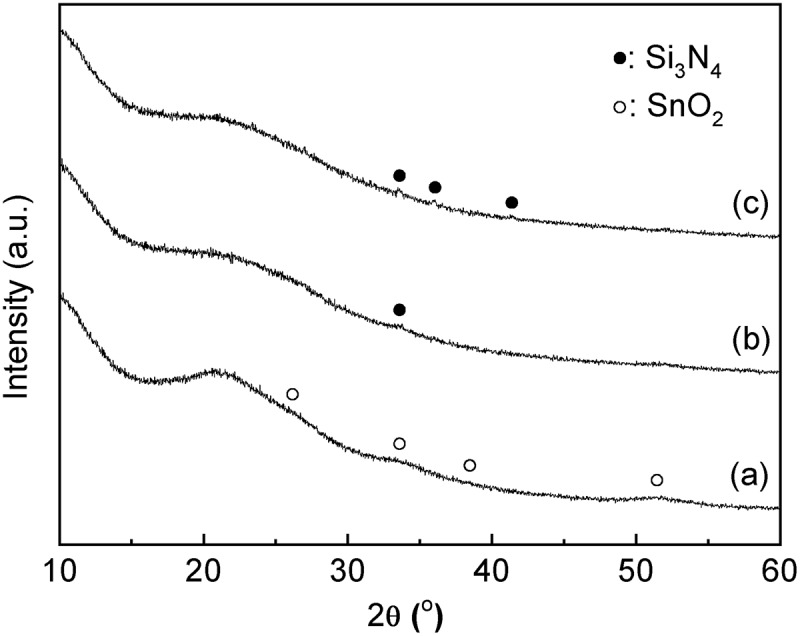
XRD patterns of a mixture of the amorphous Sn(OH)4 powder and fumed silica for the Si/Sn molar ratio of 20; (a) before the mechanochemical treatment; (b) after grinding for 12 h, g(SiO2–SnO2)12; (c) after grinding for 24 h, g(SiO2–SnO2)24 (all patterns are vertically offset for clarity).